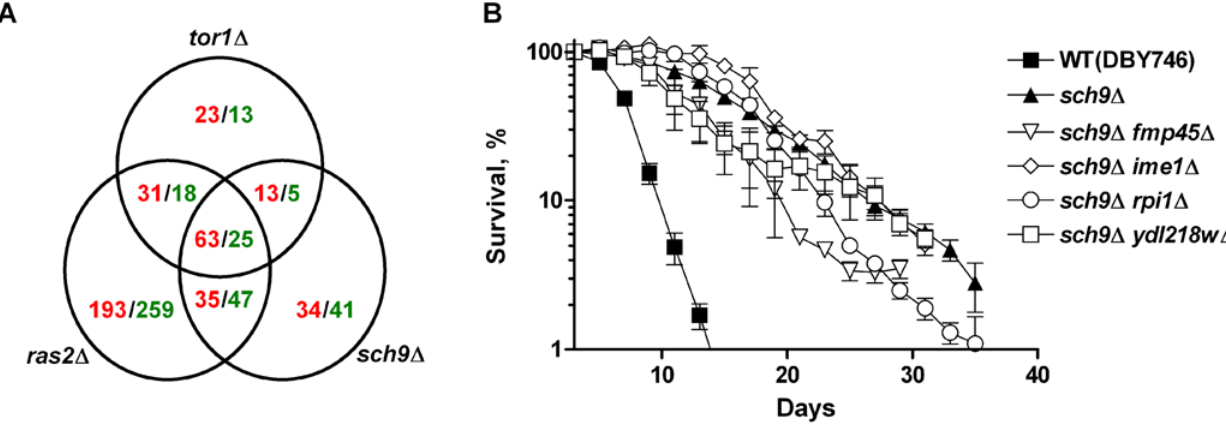
Figure 2. Gene-expression profiles of long-lived mutants. (A) Venn diagram of genes up- or down-regulated more than 2-fold in the tor1 D , sch9 D , and ras2 D mutants, at day 2.5, compared to wild type cells (DBY746). Microarray analyses were carried out in triplicates. The number of up- or down-regulated genes was shown in red or green, respectively. For the significance of overlapping in up- and down-regulated genes see Table S3. (B) Life span of mutants with deletions of genes most upregulated in long-lived mutants in the sch9 D background. Data represent mean and SEM of pair matched, pooled experiments. For mean life span calculated from non-linear curve fitting see Table S1.